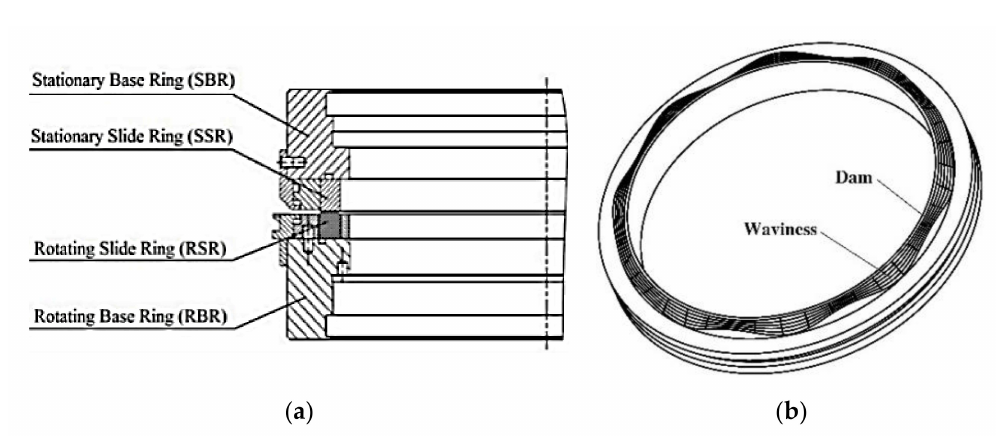
Figure 1. Schematic of the mechanical seal, including ( a ) mechanical seal configuration and ( b ) stationary slide ring